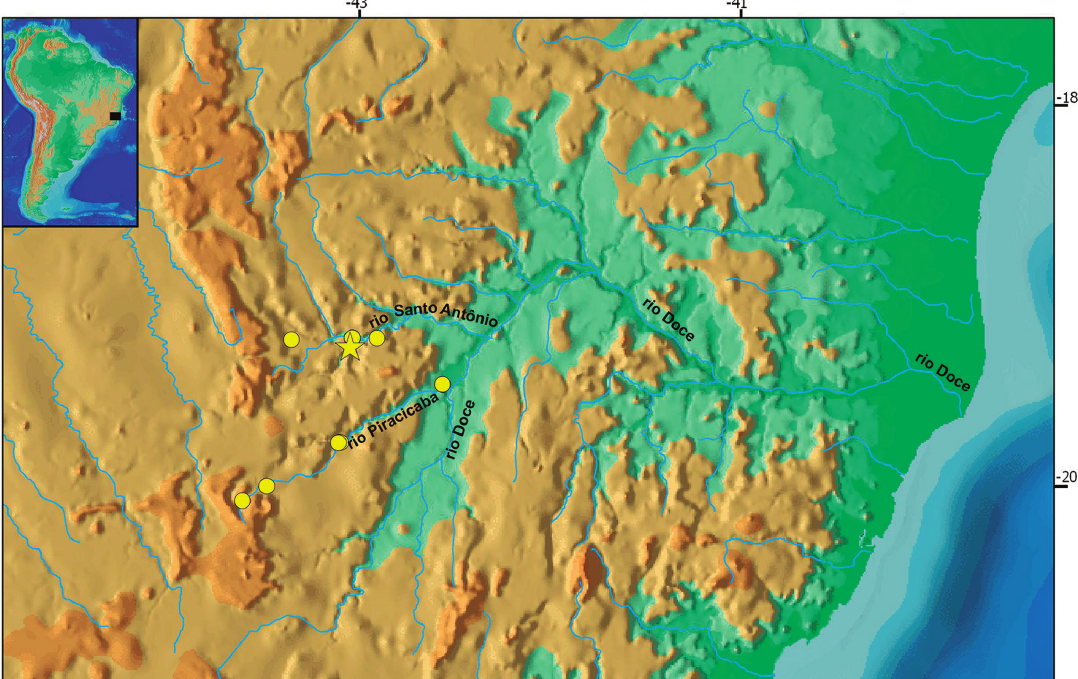
Fig. 7. Rio Doce drainage with the distribution of Deuterodon pedri , southeastern Brazil. The star indicates the type